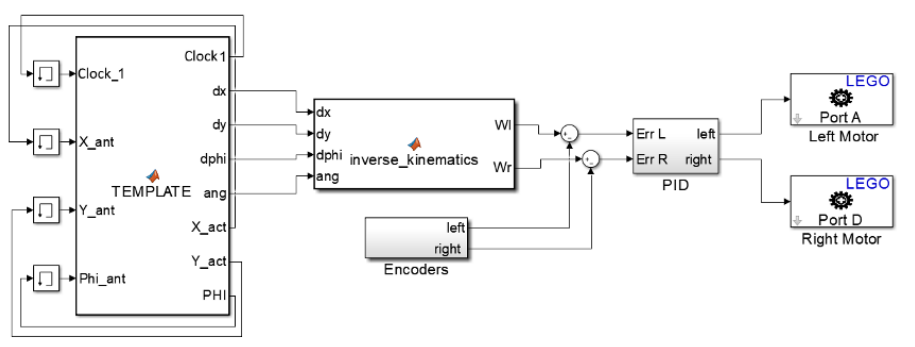
Figure 2. Simulink block diagram of the LEGO EV3 robot control application. (courtesy of Springer Nature [5]).